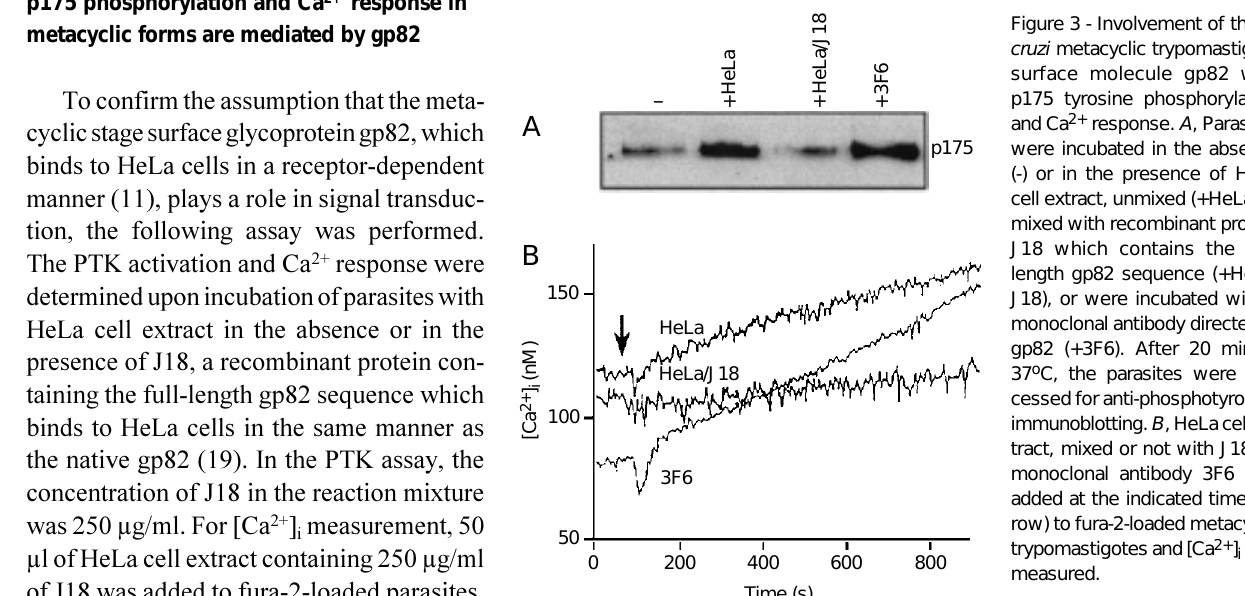
Figure 2 - Inhibition of T. cruzi metacyclic trypomastigote p175 phosphorylation and Ca 2+ signal- ing by genistein. A , Metacyclic forms, untreated (Meta) or treated with 250 µM of protein tyrosine kinase inhibitor genis- tein (Meta*), were incubated in the absence (-) or in the pres- ence (+) of HeLa cell extract at 37 o C for 20 min, and then pro- cessed for anti-phosphotyrosine immunoblotting. B , HeLa cell extract was added at the indi- cated time (arrow) to fura-2- loaded parasites, untreated (Meta) or treated with 250 µM genistein (Meta*), and [Ca 2+ ] i was measured. Results repre- sentative of three experiments are